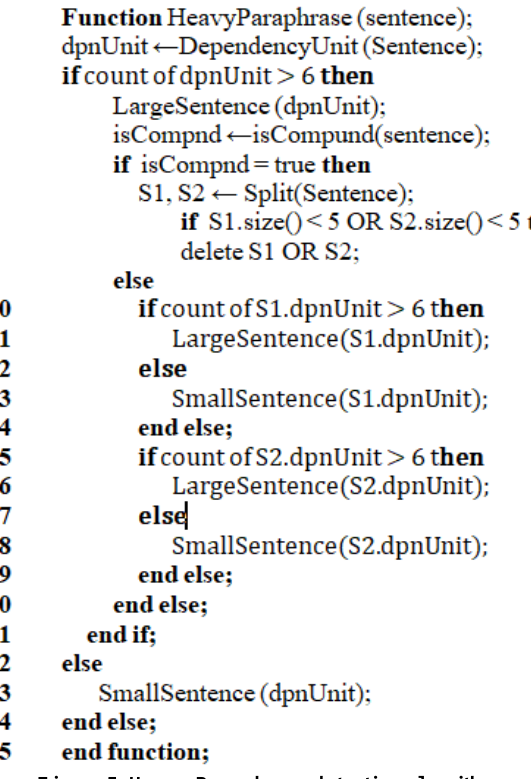
Figure 5. Heavy Paraphrase detection algorithm. Figure 6.Cancel SenParaMaker flowchart to detect